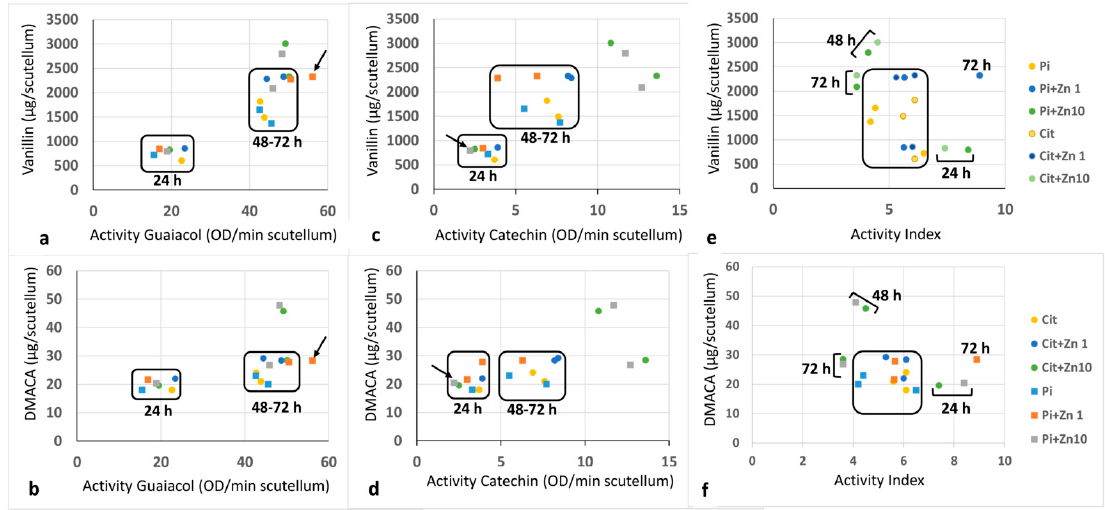
Figure 8. Relationship between peroxidase activity and the concentration of flavonoids. The association of POD-Gua, POD-Cat, or the activity index (AI) with the concentration of flavonoids quantified with the vanillin or DMACA method is shown for the different imbibition times and media. The grouping of values for the experimental conditions is shown in boxes, and the values dispersed from this grouping are indicated, along with the experimental conditions and imbibition times to which they belong. ( a , c , e ): Quantification of flavonoids with the vanillin method. ( b , d , f ): Quantification of flavonoids with the DMACA method. ( a , b ), Relationship between flavonoids and POD-Gua; ( c , d ): Relationship of flavonoids with POD-Cat; ( e , f ): Relationship of the concentration of flavonoids with the AI.